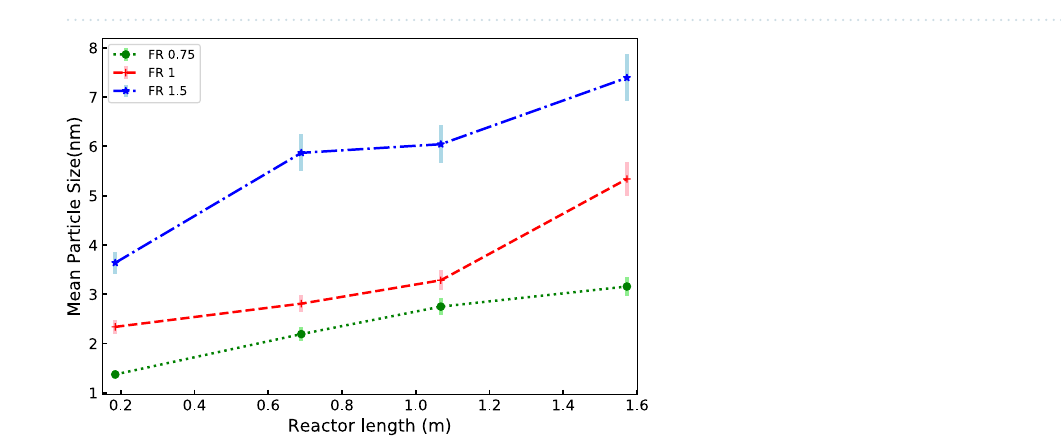
Figure 12. Development of normalized particle size distributions with different flow ratios for FS1 along the length of the reactor: ( a ) FR = 0.75 , ( b ) FR = 1.0 , and ( c ) FR = 1.5 .